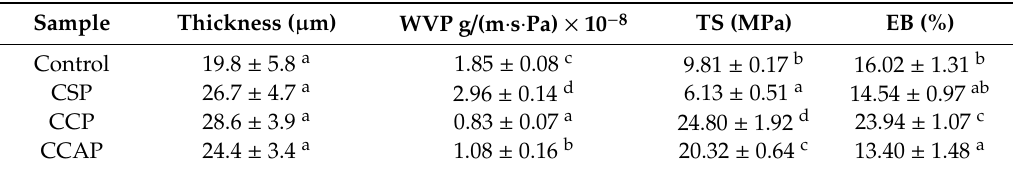
Table 1. Thickness, water vapor permeability (WVP), tensile strength (TS) and elongation at break (EB) of chitosan films and films containing